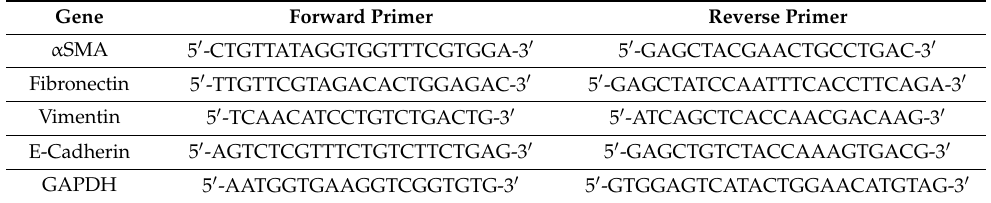
Table 1. PCR primer